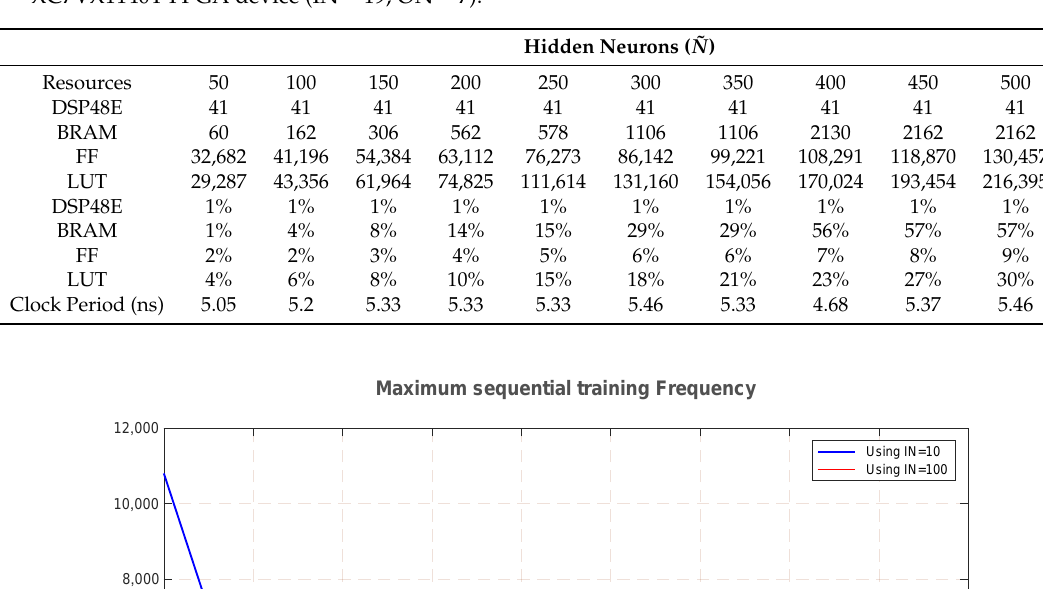
Table 1. Resource usage and clock period as a function of the number of hidden neurons. Resource usage is indicated both as the number of slices and as the percentage of occupation on a Xilinx Virtex-7 XC7VX1140T FPGA device (IN = 19, ON = 7).